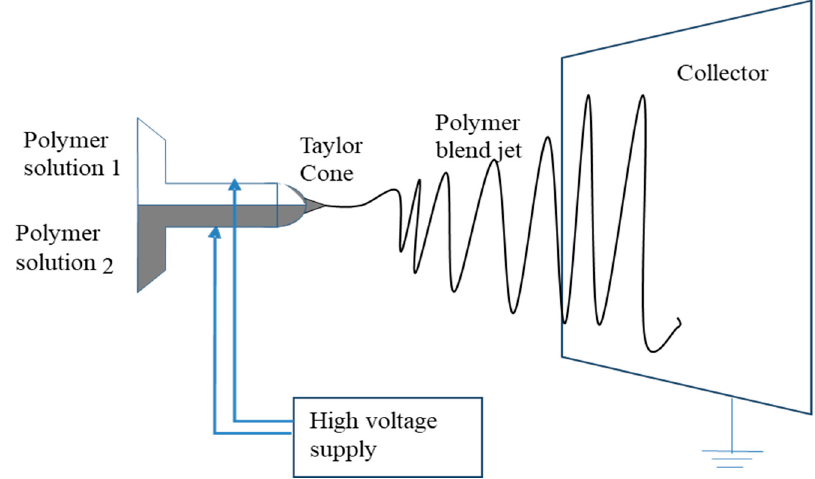
Figure 3. Side-by-side electrospinning schematic diagram: Polymer solutions 1 and 2 pass through separate capillaries, which are connected to the same high voltage supply, at either the same or different rates. A single Taylor cone is formed, which ejects the jet with non-uniform mixture of both the polymer solutions and, after drying, is deposited on the collector.